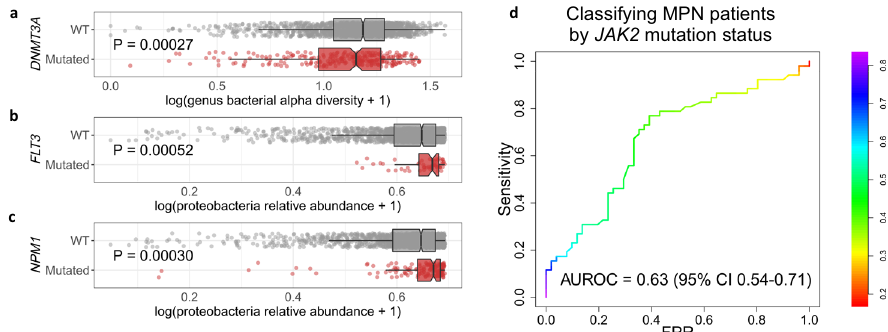
Fig. 6 Associations between gene mutations and microbial characteristics. a Genus α -diversity strati fi ed by DNMT3A mutation status (1580 WT, 259 mutated). b , c Proteobacteria relative abundance strati fi ed by FLT3 (1804 WT, 56 mutated) and NPM1 (1698 WT, 167 mutated) mutation status. In boxplots, bounds of box indicate fi rst and third quartiles, center line indicates median, and whiskers extend to ( fi rst quartile − 1.5 × IQR) and (third quartile + 1.5 × IQR) or extrema, whichever is less extreme (here IQR = interquartile range, i.e. third quartile – fi rst quartile). P -values are from a two-sided logistic regression-based test. d ROC curve for random forest algorithm to classify MPN patients by JAK2 mutation status from microbial content. The random forest generates a probability of a sample having a JAK2 mutation. The color bar indicates varying thresholds of this probability for calling the sample as having the mutation. WT wild type, AUROC area under receiver operating characteristic curve, CI con fi dence interval, FPR false positive